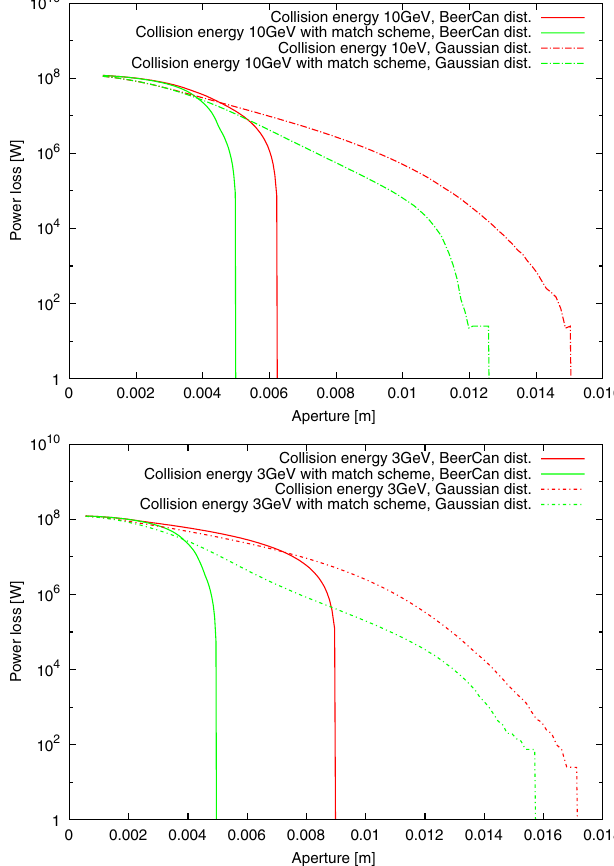
energy 10GeV, BeerCan dist. Collision energy 10GeV with match scheme, BeerCan dist. Collision energy 10eV, Gaussian dist. Collision energy 10GeV with match scheme, Gaussian dist.